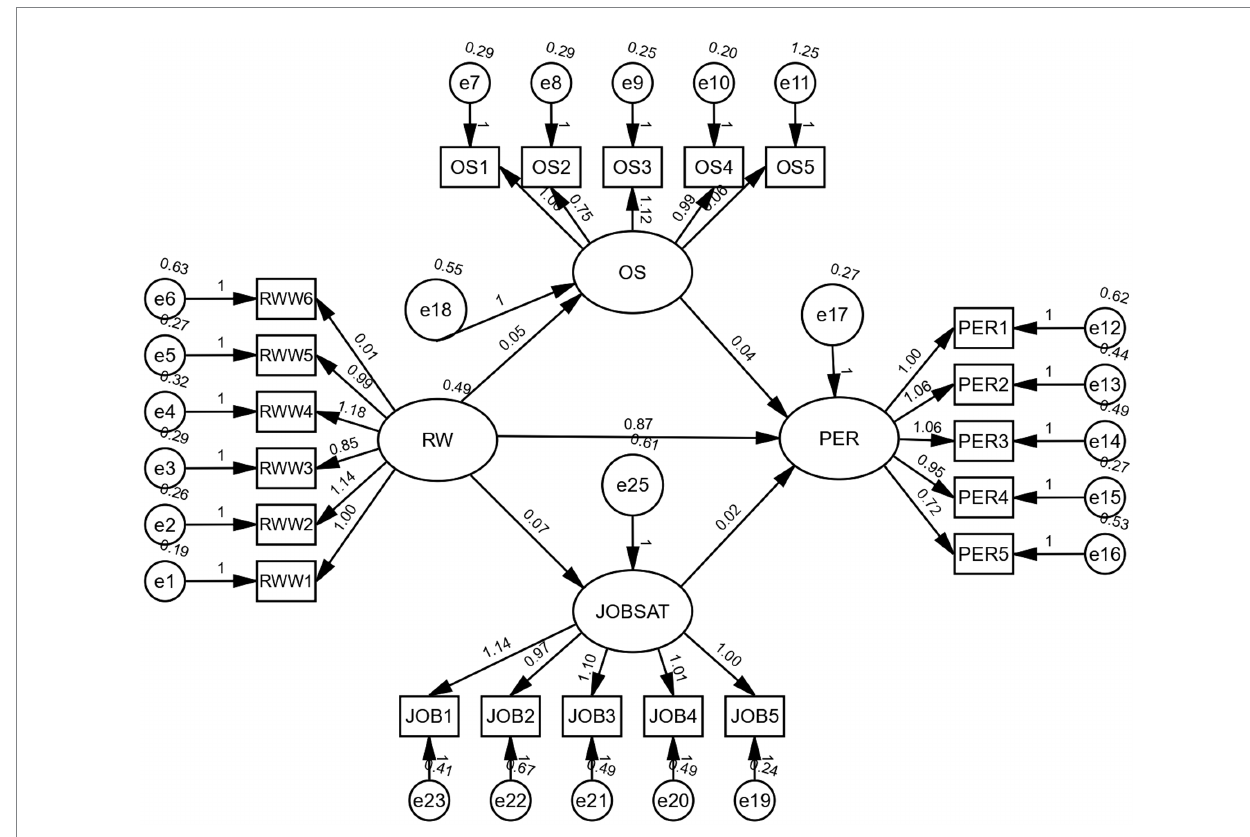
FIGURE 2 Mediation analysis. REMWOR, remote working; PERFO, performance; Stress, occupational stress; JOB, job satisfaction; RWW, remote working; OS, occupational stress; and PER,